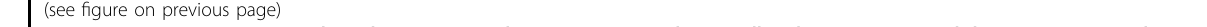
Fig. 6 HBO increases tumour volume but promotes chemosensitization due to cell cycle progression and decreases stemness by inhibiting HIF1 α /HIF2 α -Sox2. A GBM cells after HBO exposure had a low proportion of cells in the G 1 phase and a high proportion of cells in the G 2 /M + S phase. B HIF-ko cells were cultured in 1% O 2 for 72 h, and the proportion of cells in the G 1 phase decreased and the proportion of cells in the G 2 /M + S phase increased after dual HIF1 α /HIF2 α knockout. Moreover, the proportion of cells in the G 1 phase was lower and the proportion of cells in the G 2 /M + S phase was higher in dual HIF1 α /HIF2 α -KO cells than in individual HIF1 α - or HIF2 α -KO cells. However, cell cycle changes were not signi fi cantly different between the HIF1 α - or HIF2 α -KO individual group and the empty vector control group. C There were no signi fi cant differences between the control and empty vector groups, but there was a decrease in the proportion of cells in the G 1 phase and an increase in the proportion of cells in the